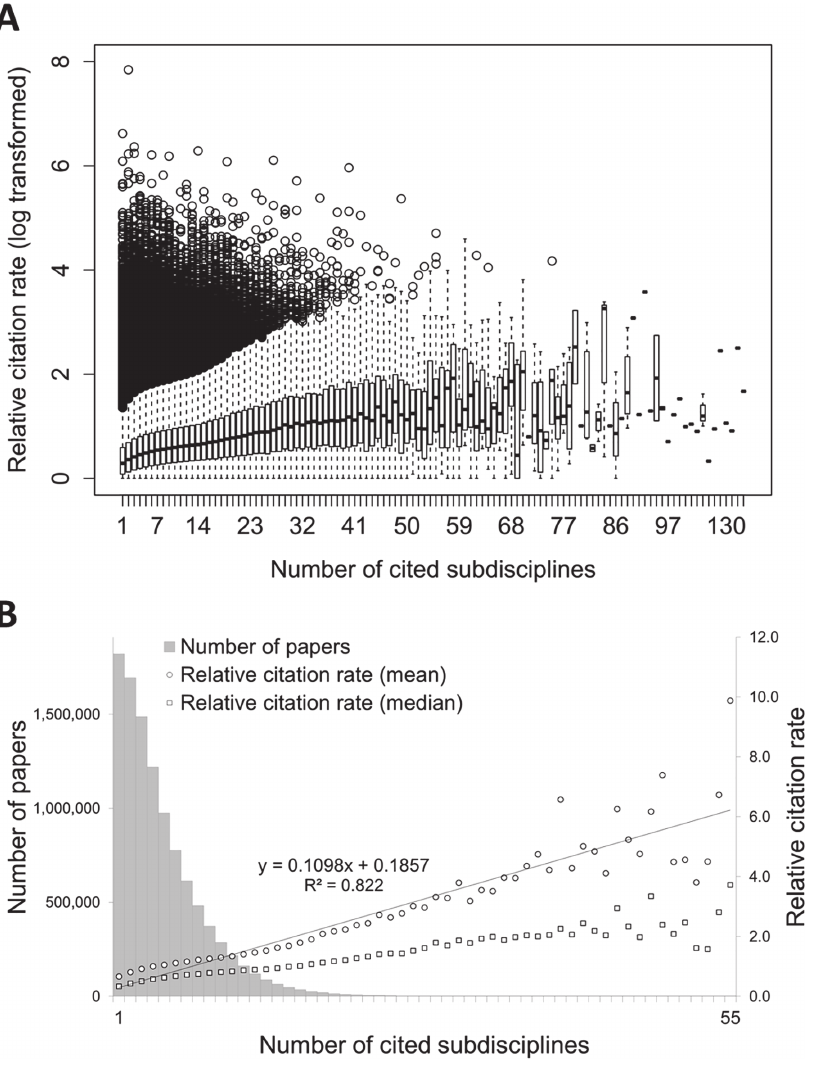
Fig 1. Number of papers and relative citation rates of papers that cite between 1 and 55 subdisciplines.